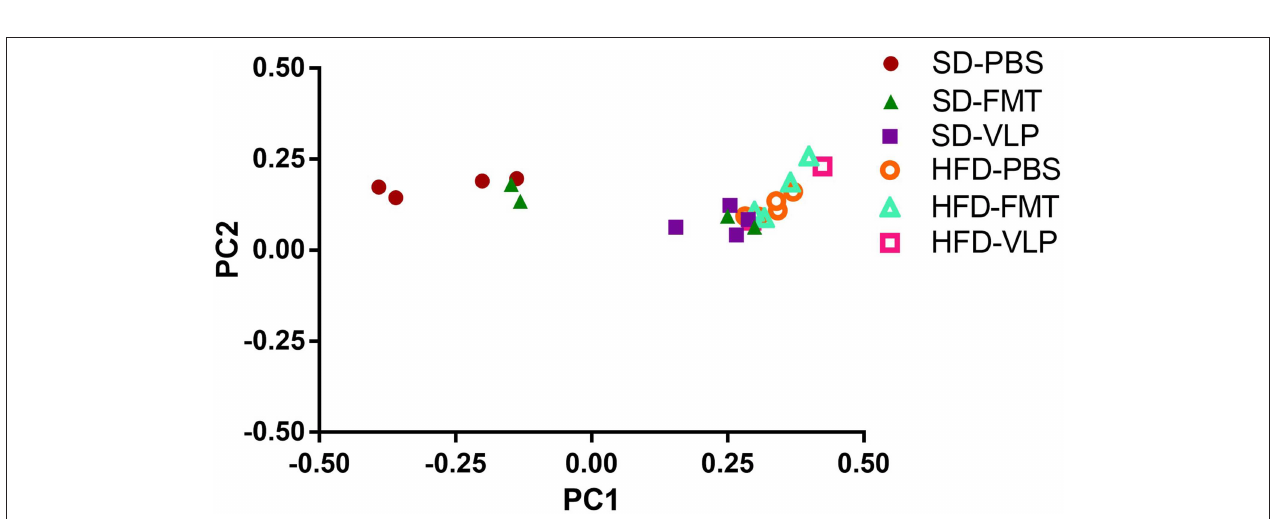
FIGURE 7 | Principal coordinates analysis plot of weighted UniFrac distances for ileal microbiome beta diversity. A total of 13 mice were excluded from analysis due to low abundance after rarefaction: one from HFD-PBS, two each from SD-PBS, SD-FMT, SD-VLP, and HFD-FMT, and four from